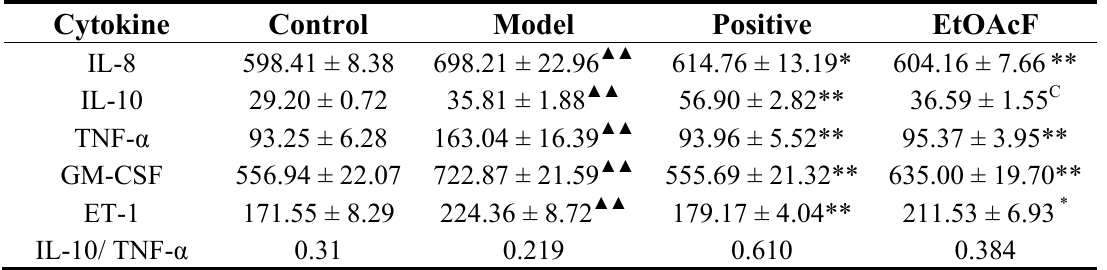
Table 2. Changes of cytokine in rat serum with cigarette inhalation in stable COPD phase